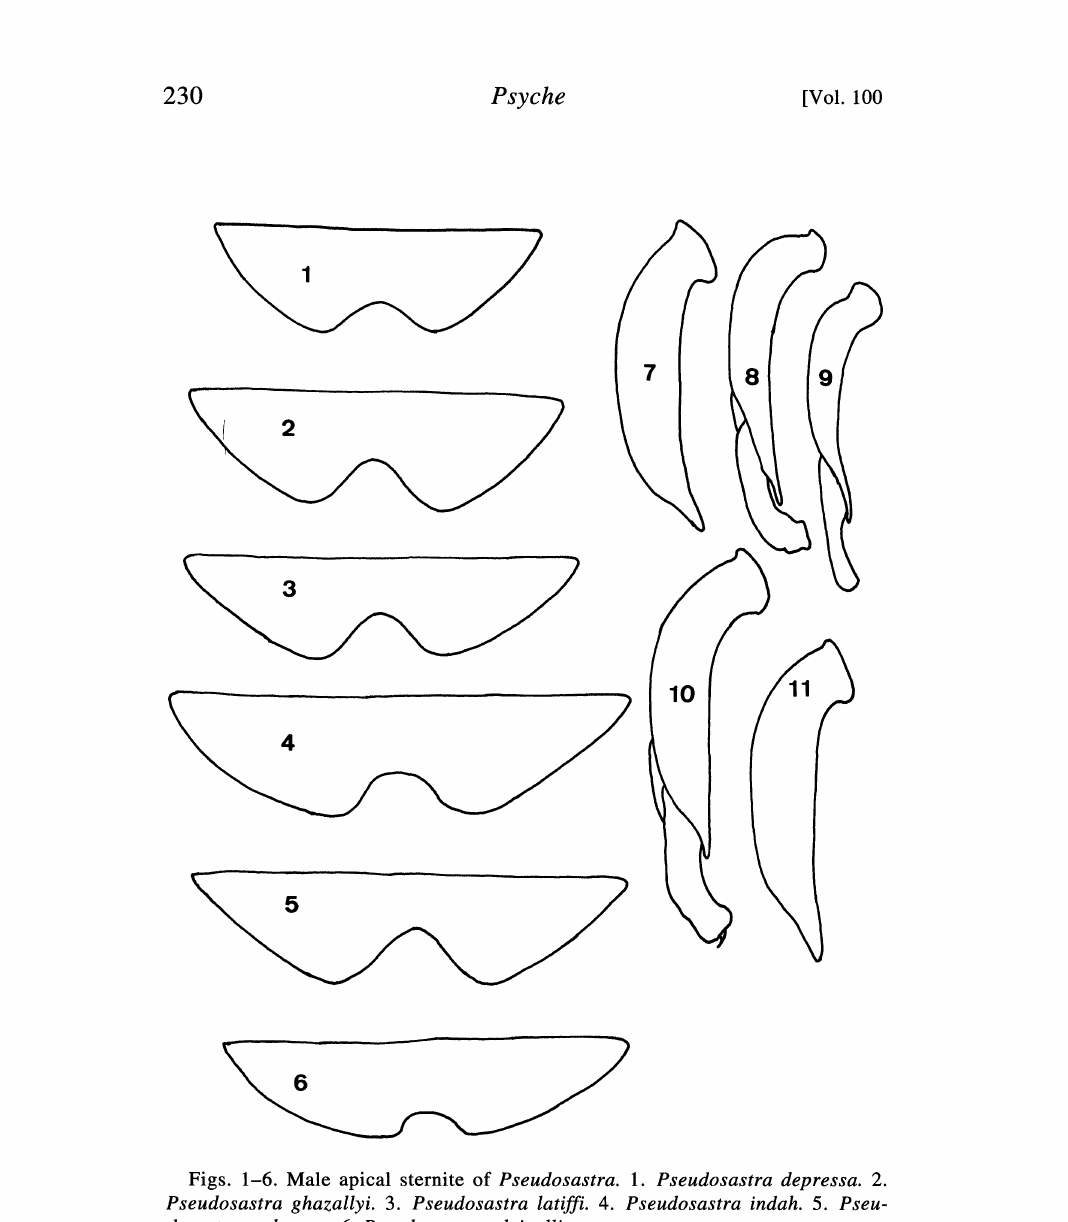
Figs. 1-6. Male apical sternite of Pseudosastra. 1. Pseudosastra depressa. 2. Pseudosastra ghazallyi. 3. Pseudosastra latiffi. 4. Pseudosastra indah. 5. Pseu- dosastra malayana. 6. Pseudosastra sulcicollis. Figs. 7-11. Aedeagi of Pseudosastra, lateral view. 7. Pseudosastra depressa. 8. Pseudosastra ghazallyi. 9. Pseudosastra latiffi. 10. Pseudosastra indah. 11. Pseu- dosastra